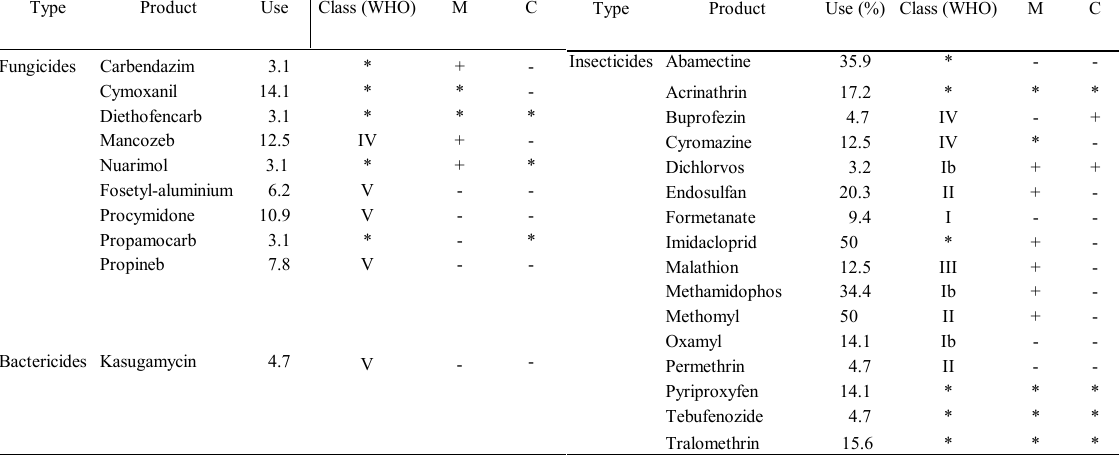
*, Not available: -, no observed effects; +, adverse effects in at least one experiment (See M.L.Richardson, 1992, for more detailed information).